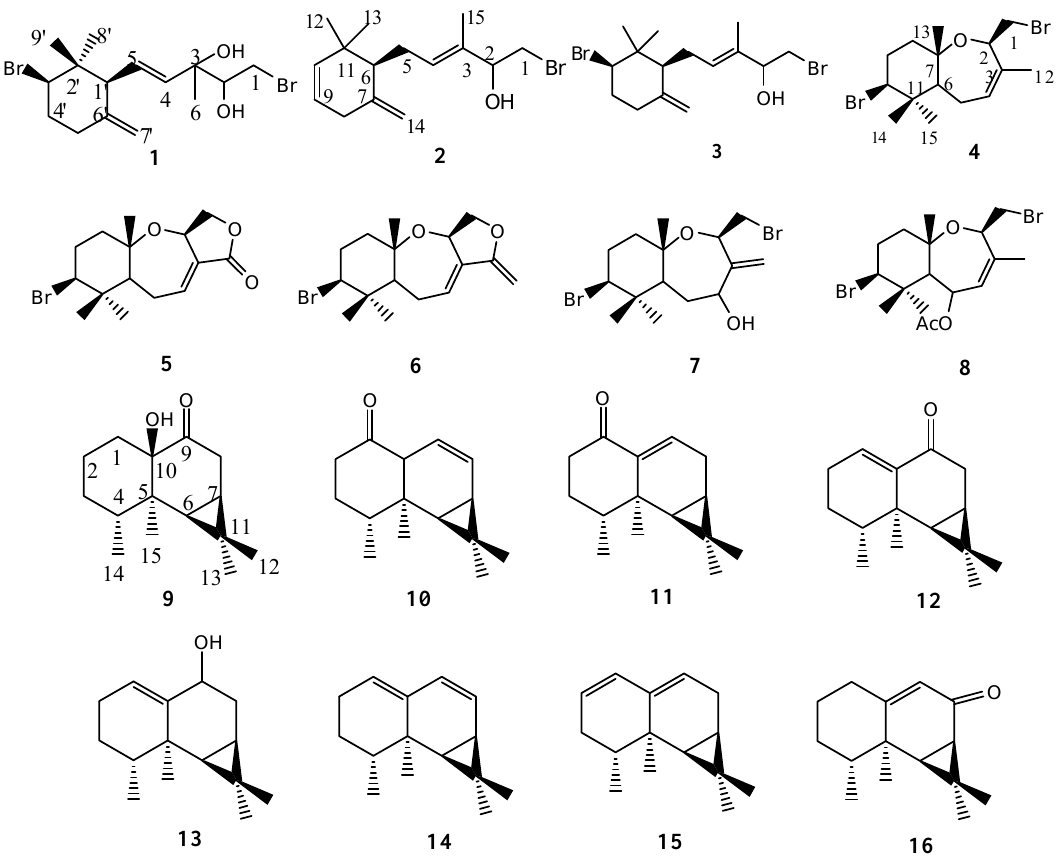
Figure 1. Structure of compounds 1 to 16